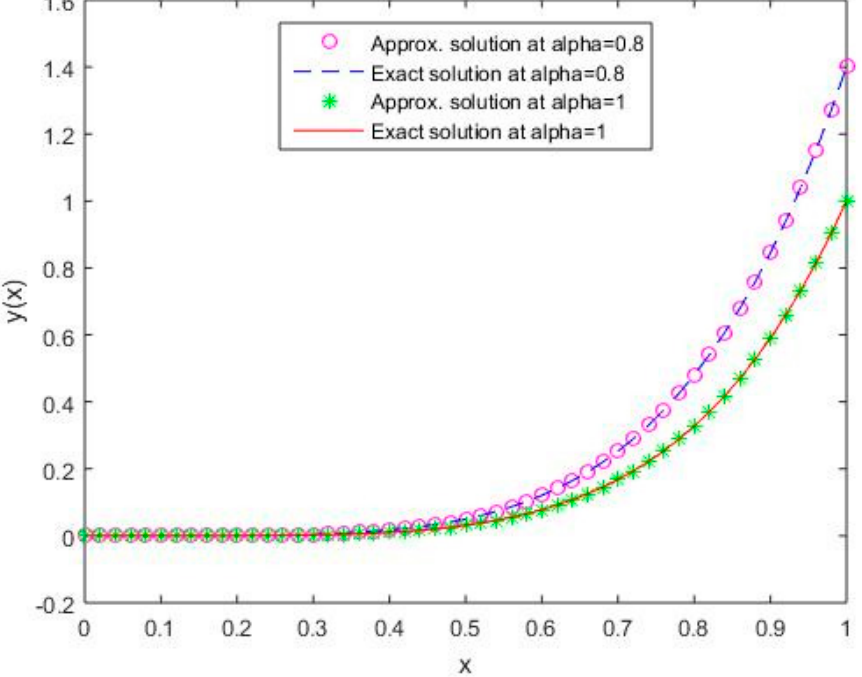
Figure 4. Comparison of exact and numerical solutions using S4 for 𝛼 = 0.8 and 𝛼 = 1 , Example 1.